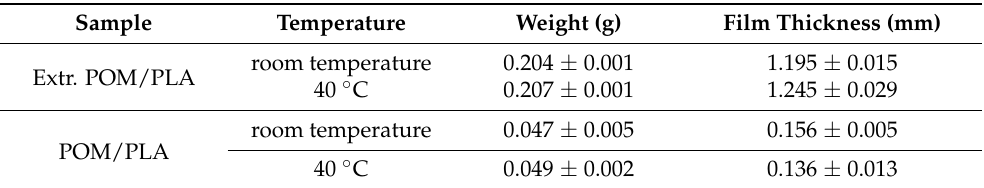
Table 4. The main characteristics of the POM/PLA composite films after 10 days of immersion in Milli-Q water at different temperature.